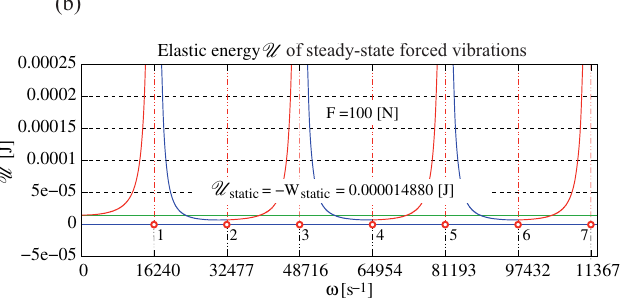
Fig. 8. Steady-state frequency response curves of fixed-fixed bar.